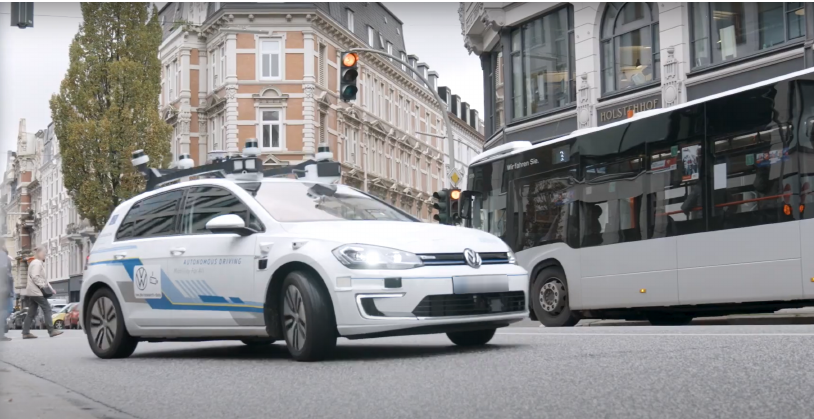
Figure 1. The UP-Drive demonstrator vehicle, based on a VW eGolf, navigates urban environments in fully automated mode at the completion of the